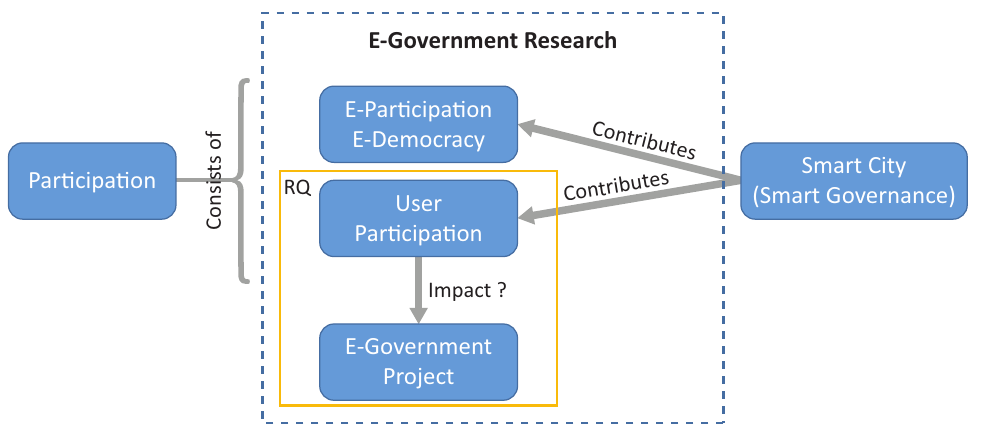
Figure 1. Background